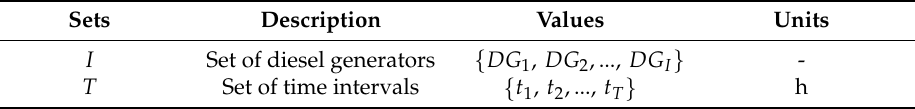
Table 1. List of sets in the LP model.